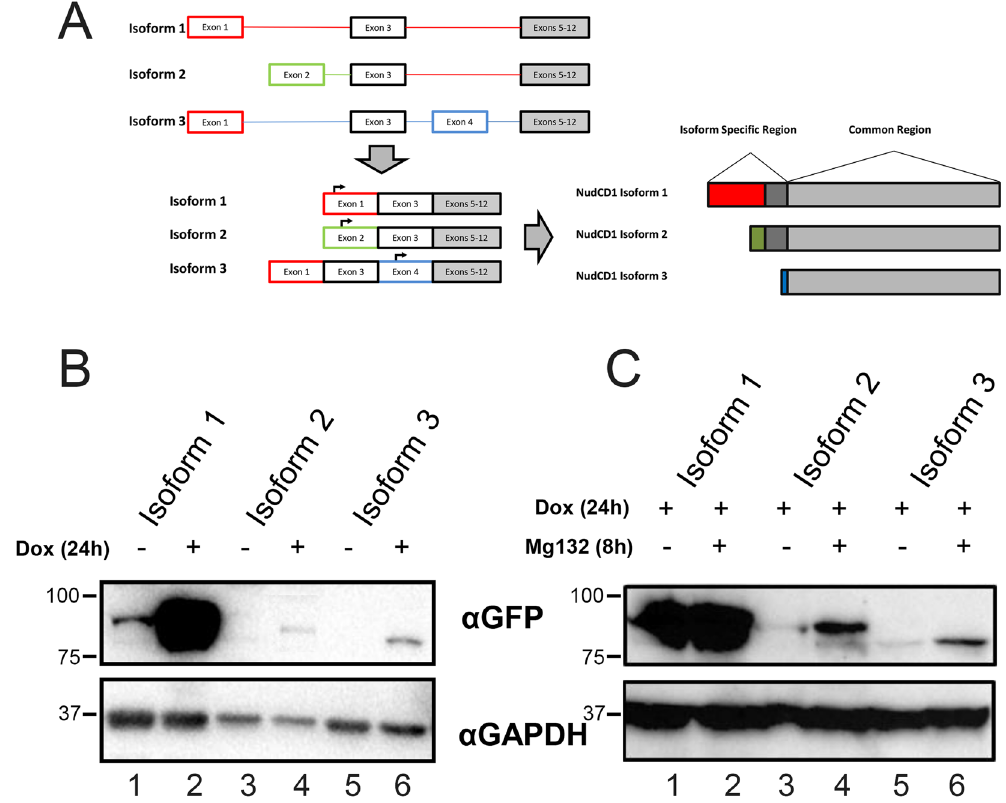
Figure 1. Alternative splicing results in three different NudCD1 isoforms. ( A ) Schematic representation of the first 4 exons of NudCD1 and the resulting isoforms that differs in their N-termimus, while all isoforms include exons 5 to 12. Isoform 1 consists of exons 1 and 3, isoform 2 consists of exons 2 and 3, while the isoform 3 includes the exons 1, 3 and 4, but uses an initiation codon in the fourth exon, resulting in a smaller protein. ( B ) Total protein lysates from U2OS FT cells with doxycycline-induced GFP-tagged NudCD1 isoforms were analyzed by Western blotting using a GFP antibody to confirm expression of the different isoforms following induction using doxycycline (lane 2, 4, 6). ( C ) Total protein lysates from U2OS FT cells with doxycycline- induced GFP-tagged NudCD1 isoforms treated or not with MG132 were analyzed by Western blotting using a GFP